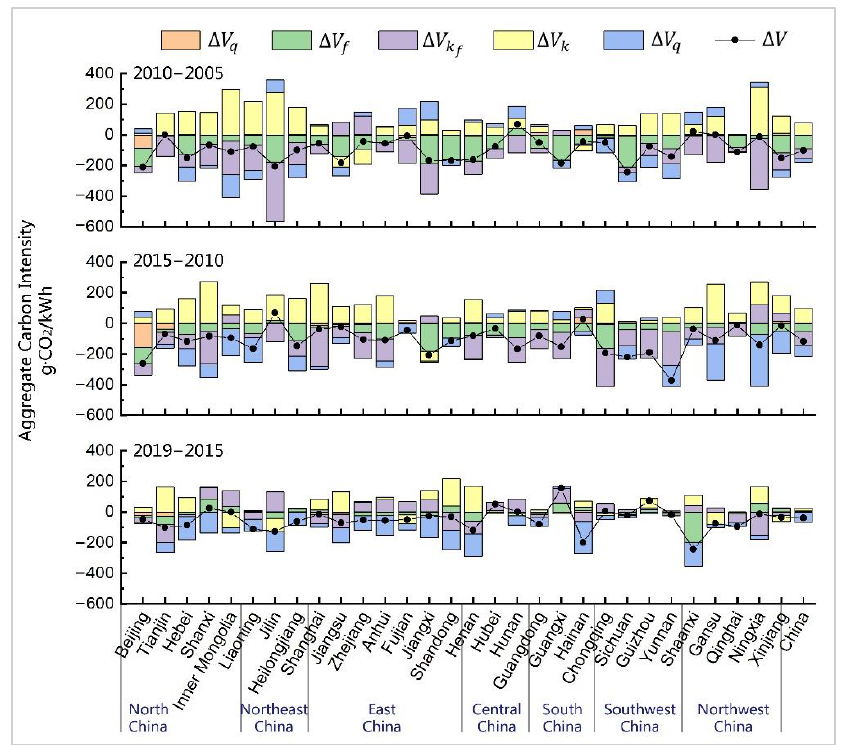
Figure 2. Performance of driving factors in provincial temporal IDA-LMDI.